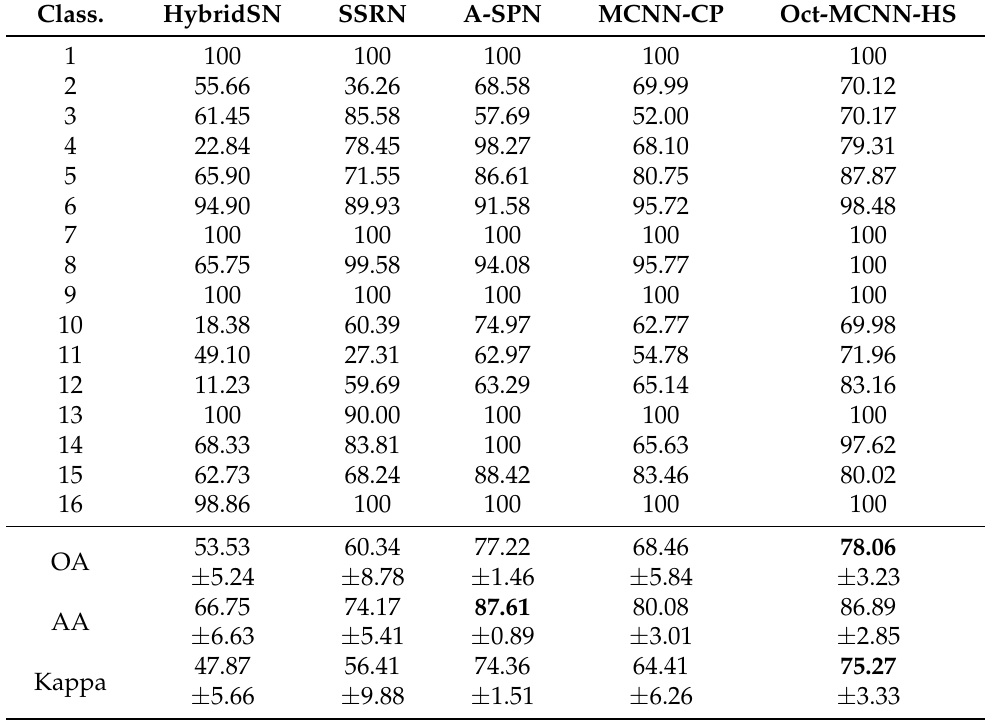
Table 6. Results (%) for the Indian Pines dataset with 80 training samples.